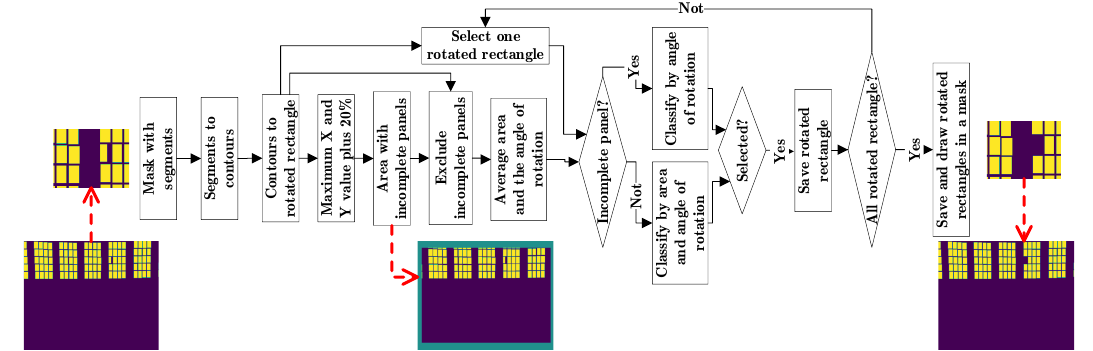
Figure 6. Selection of the contours of the detected panels, one panel is missing.